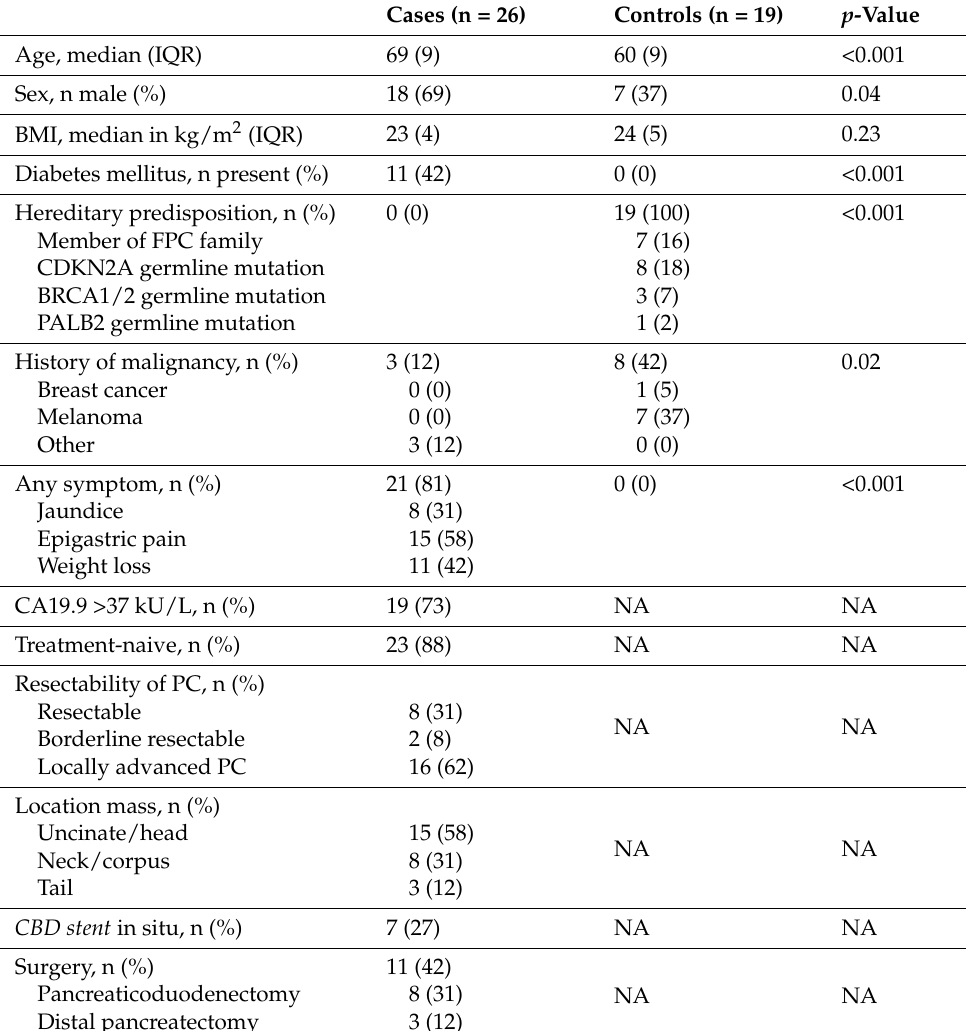
Table 1. Patient